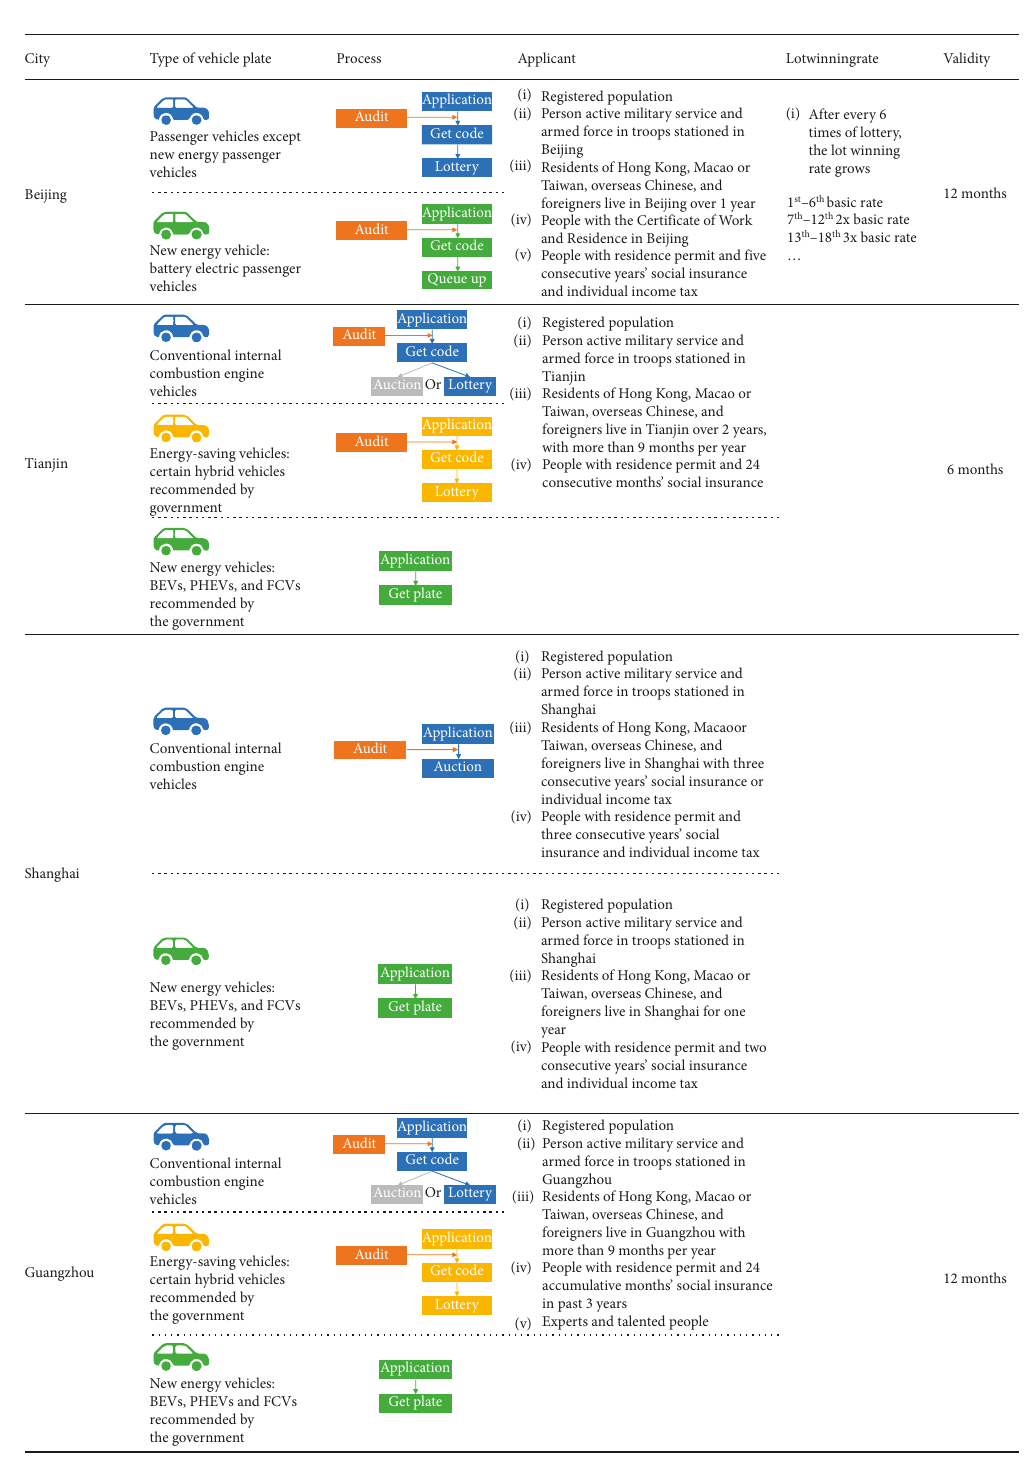
Figure 4: Details of vehicle purchase restriction policies in Beijing, Tianjin, Shanghai, and